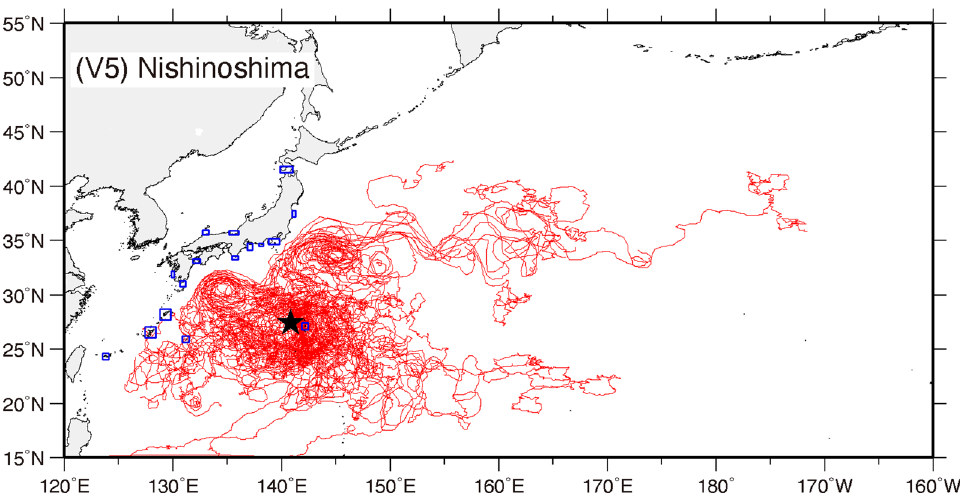
Fig. 12 Simulated drift paths of 50 randomly selected virtual pumice clasts released from (V5) Nishinoshima (black star) on 15 March 2004. Blue rectangles indicate target